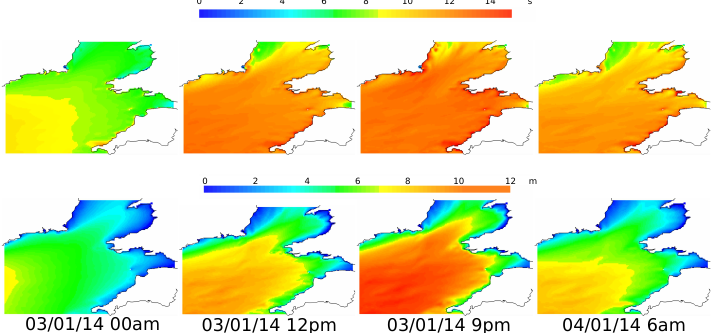
Figure 7. WAVEWATCH III wave height and spectral period output leading up to and after Storm A. Date provided as dd/mm/yy.